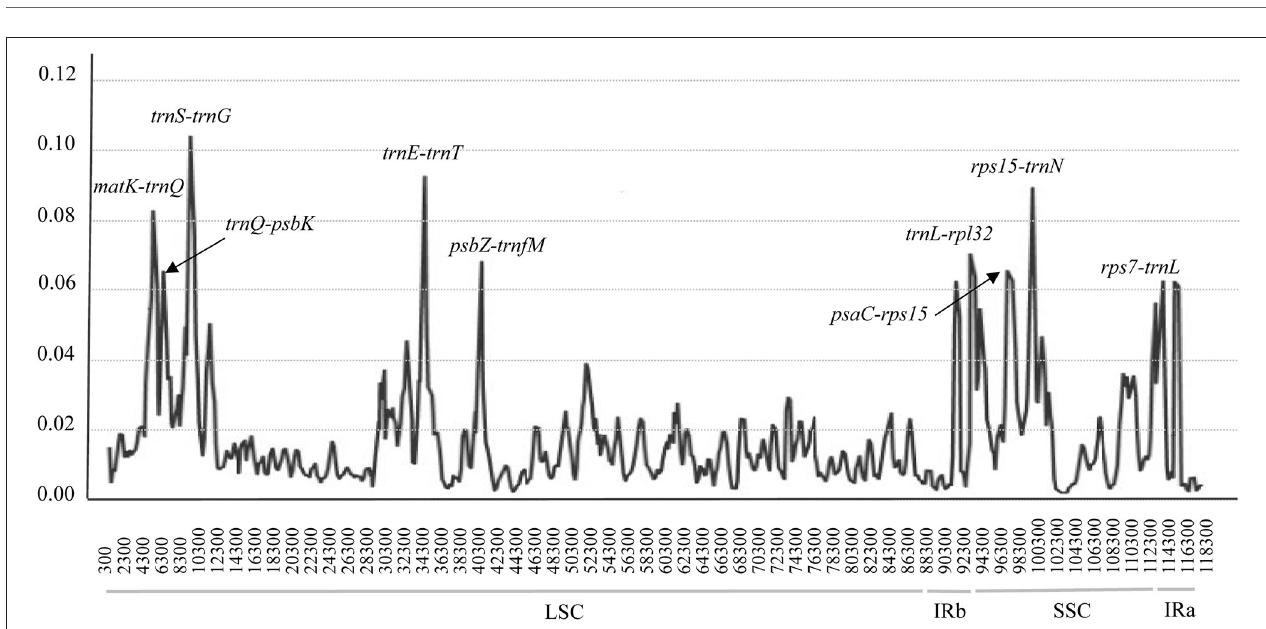
FIGURE 4 | Hypervariable regions within cp genomes of species of Zygophyllum using a sliding window analysis. Window lengths: 600 bp; step size: 200 bp. Nine regions with the highest Pi values were marked out. LSC: large single-copy region, IR: inverted repeat region, SSC: small single-copy region. x -axis: position of the midpoint of a window; y -axis: nucleotide diversity of each window.